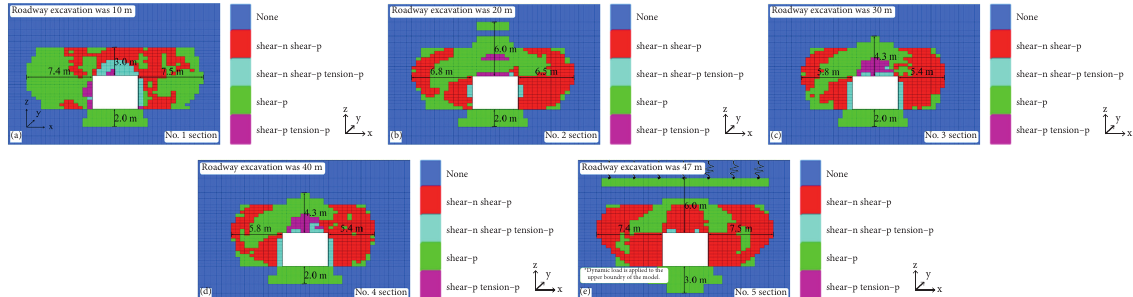
Figure 10: Distribution of surrounding rock plastic zone during roadway excavation. Roadway excavation was (a) 10m, (b) 20 m, (c) 30m, (d) 40m, and (e) 47m.